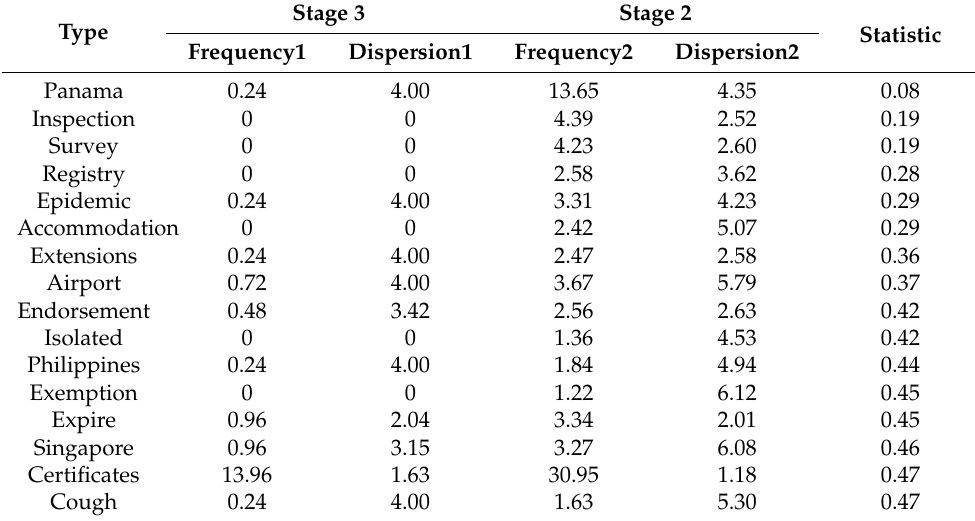
Table 5. Negative keywords for Stage 3 to Stage